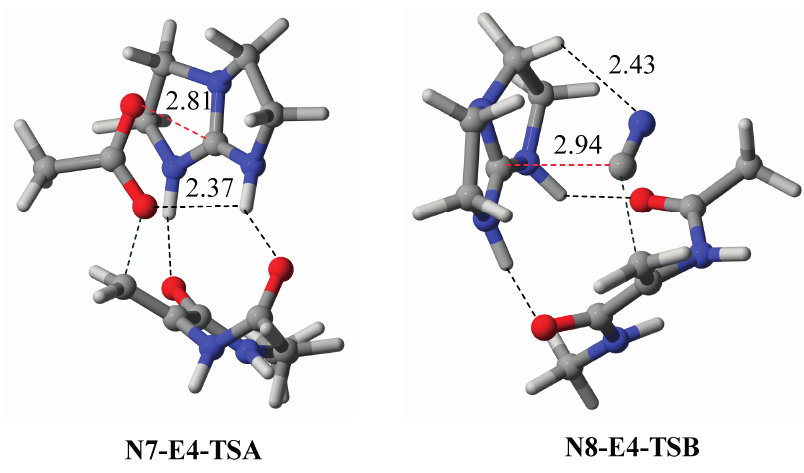
Figure 5. Optimized geometries (M06-2X/6 − 31G*) of TSB transition state for acetate ( N7-E4-TSB ) and cyanide ( N8-E4-TSB ) nucleophiles. Intermolecular interaction distances are given in Å.